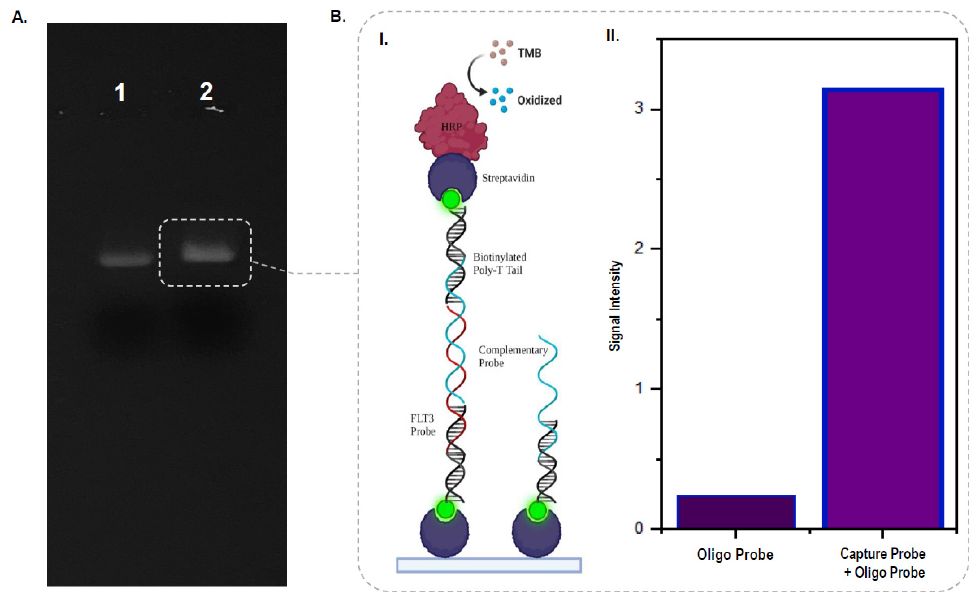
Figure 3. ( A ) Gel image showing the difference between ssDNA probe (lane 1) and poly(T) strand duplexed probe sequences (lane 2). ( B ( I )) Schematic representation of the ELISA assay used to confirm duplexed-tagging of the capture probe. ( B ( II )) Bar chart of the signal intensity measured in the presence and absence of the ssDNA capture probe.